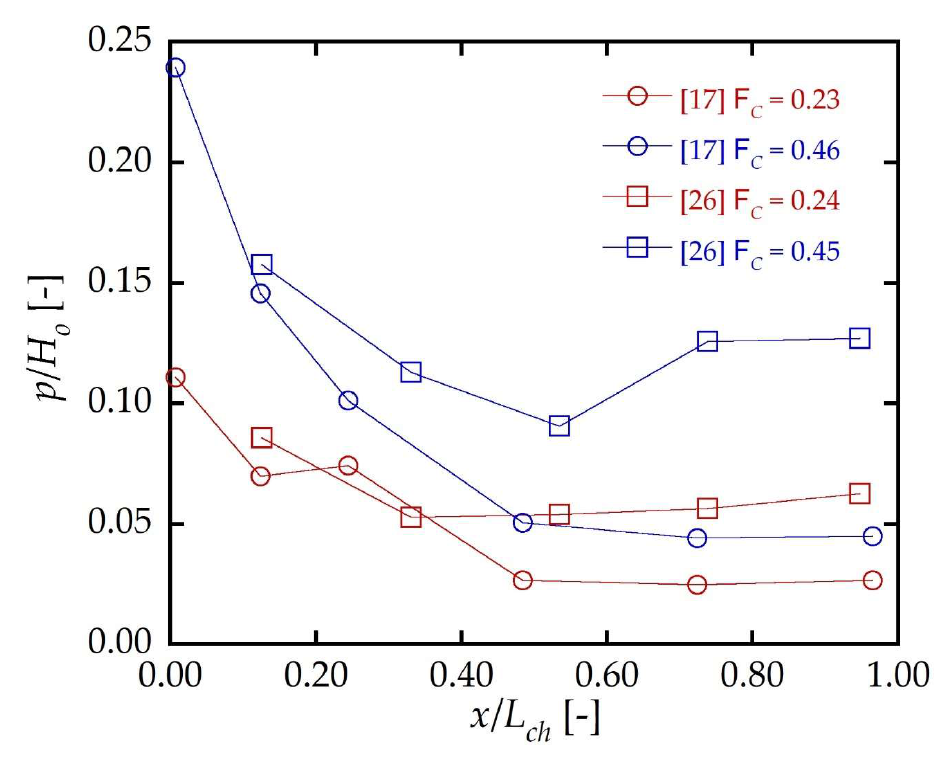
Figure 5. Maximum relative invert pressure p / H o as measured along the dissipation chamber axis.